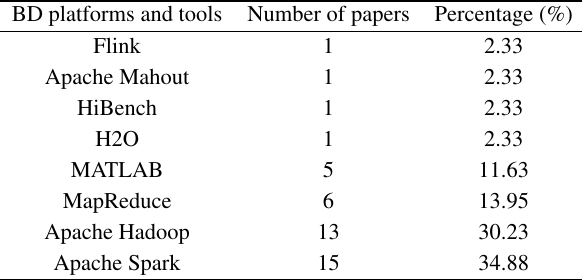
Table 2 BDA platforms and tools.